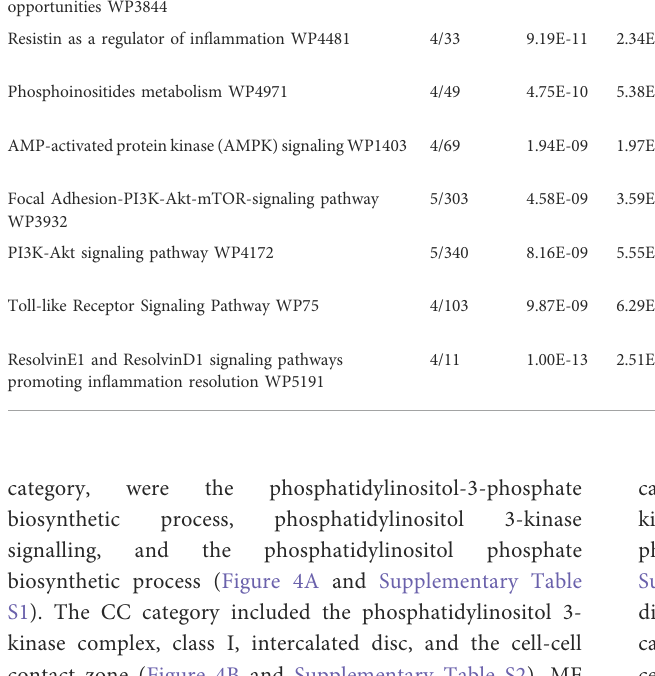
biosynthetic process (Figure 4A and Supplementary Table S1). The CC category included the phosphatidylinositol 3- kinase complex, class I, intercalated disc, and the cell-cell contact zone (Figure 4B and Supplementary Table S2). MF